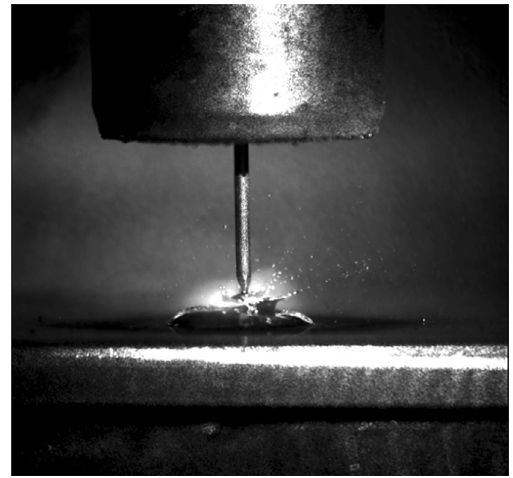
Fig. 5 Explosion taking place in spray transfer